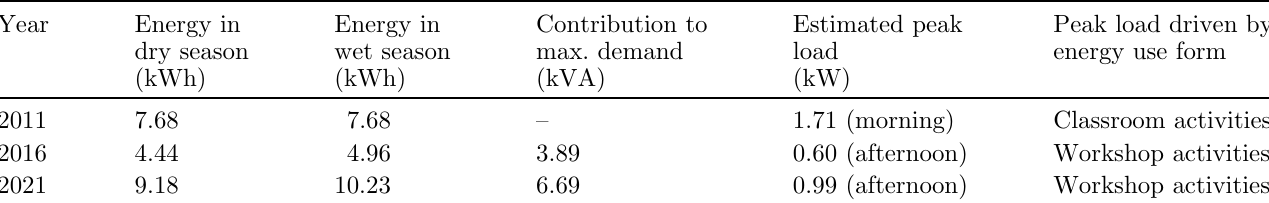
Table 2. Energy and peak load in 2011, fi eld assessment in 2016 and projections to 2021.